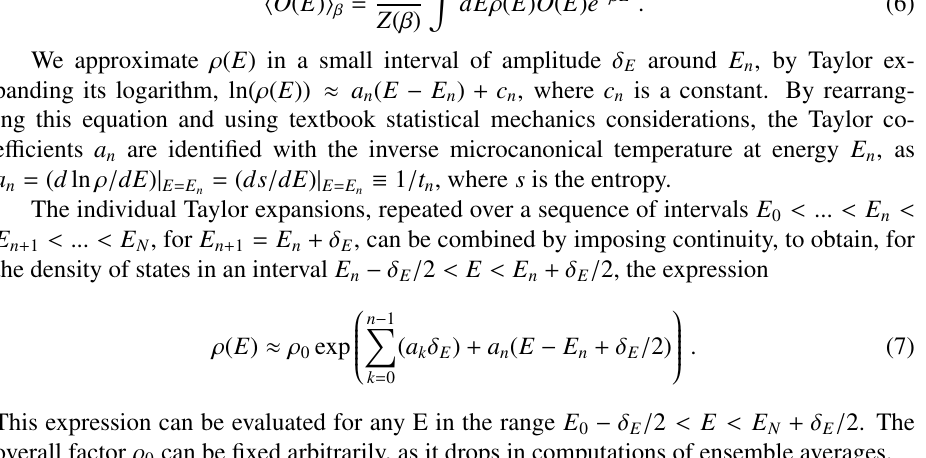
Figure 1. An sample of 20 RM trajectories for SU(3) pure gauge theory on a 4 × 20 3 lattice with periodic boundary conditions in all directions and an energy interval of size δ E / 6 ˜ V = 0 . 000374281 centred at E n / 6 ˜ V = 0 . 459324241. The inset shows the obtained a ( m ) n distribution at the truncation value m =